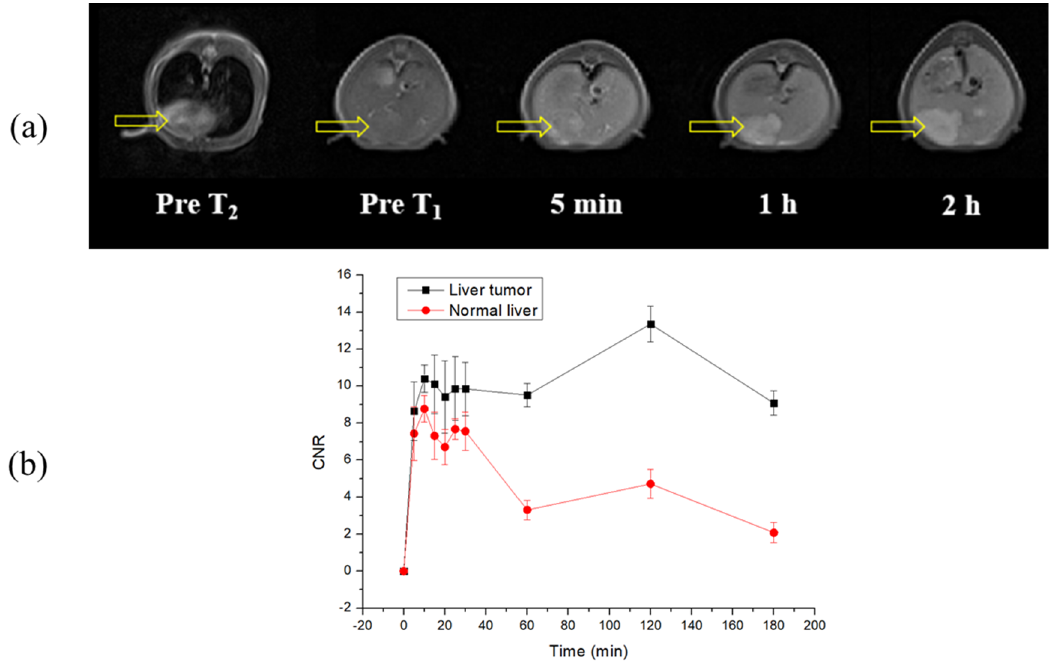
Figure 6. Axial T 2 - and T 1 -weighted MR images of HepG2 orthotopic mice ( a ) before injection and 5 min, 1 h, and 2 h post injection of Mn-NOTA-NP (0.05 mmol/kg); yellow arrows show the liver tumor lesions. ( b ) Difference of contrast-to-noise ratio (CNR) between liver tumor tissue (black squares) and normal liver parenchyma (red circles) as a function of